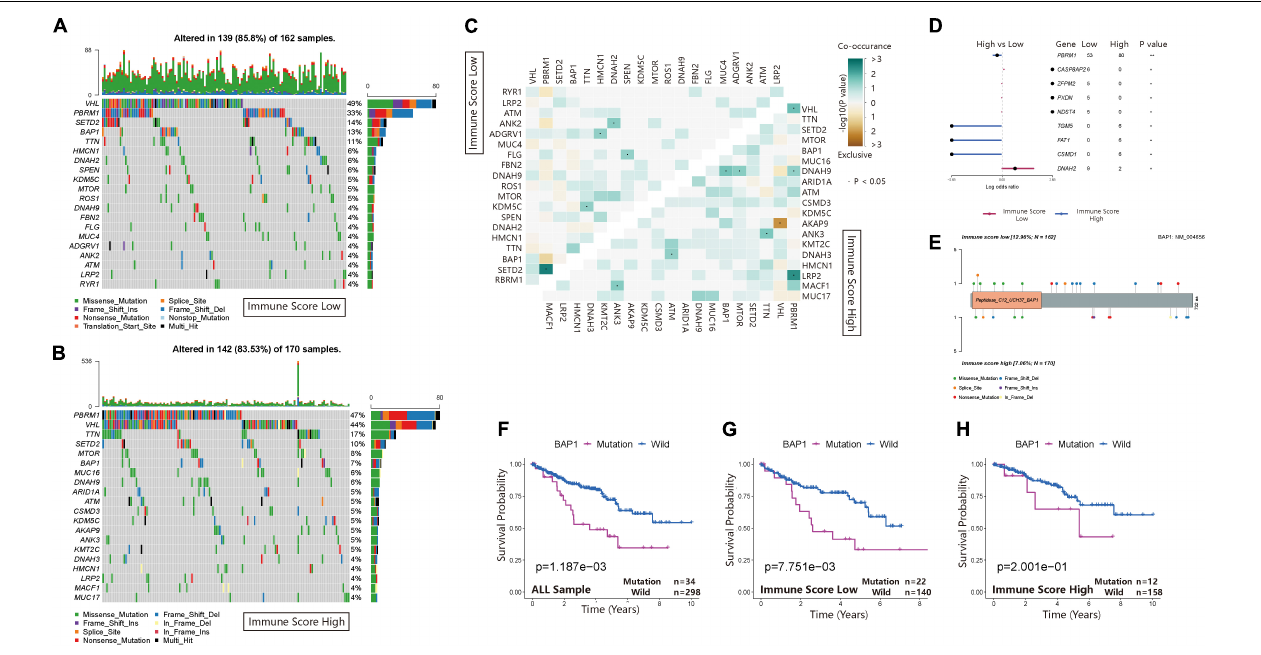
FIGURE 6 | Landscape of somatic mutations in the ISL and ISH groups. (A,B) Waterfall plot of tumor somatic mutations established by those with low immune scores (A) and high immune scores (B) . Each column represents an individual patient. The bar plot above the figure shows the tumor mutation burden (TMB), and the number on the right represents the mutation frequency of each gene. (C) The heat map shows the mutual co-occurring and exclusive mutations of the top 20 frequently mutated genes. The color or symbol of each cell represents the statistical significance of the exclusivity or co-occurrence of each pair of genes, respectively. Green represents mutual co-occurrence, and brown represents exclusive mutation. Asterisks indicate statistical p -values ( · < 0.05). (D) Forest plot of statistically significant mutant genes between the groups. Asterisks indicate statistical p -values (* < 0.05, ** < 0.01) (E) The lollipop plot illustrates the differential distribution of variants for BRCA1-associated protein 1 (BAP1). (F–H) Kaplan–Meier curves show the independent relevance between the overall survival time and BAP1 mutation in the ISL group, ISH group and all